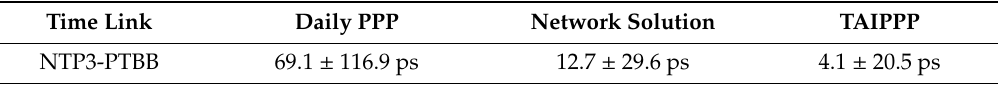
Table 4. Statistics of the day boundary discontinuities for PPP and Network solution.